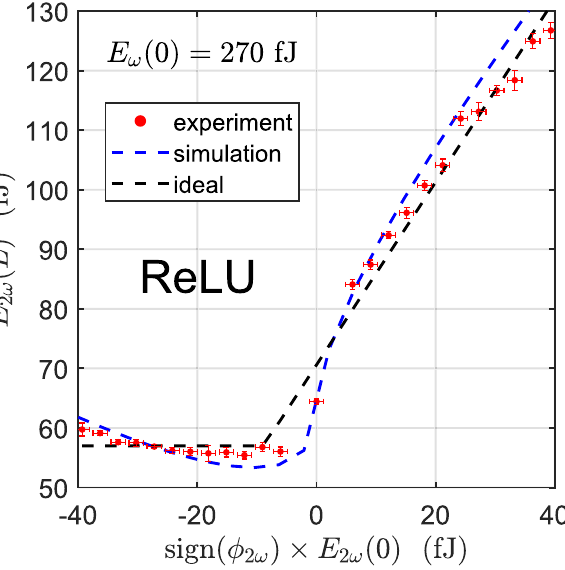
Figure 3: Output signal pulse energy versus input signal pulse energy for both negative and positive inputs. There is good agreement between the ideal ReLU function (dashed black line), simulation (dashed blue line) and experimental results (red circles) for a bias pulse energy of E 𝜔 (0) = 270 fJ, and signal pulse energies of femtojoules per